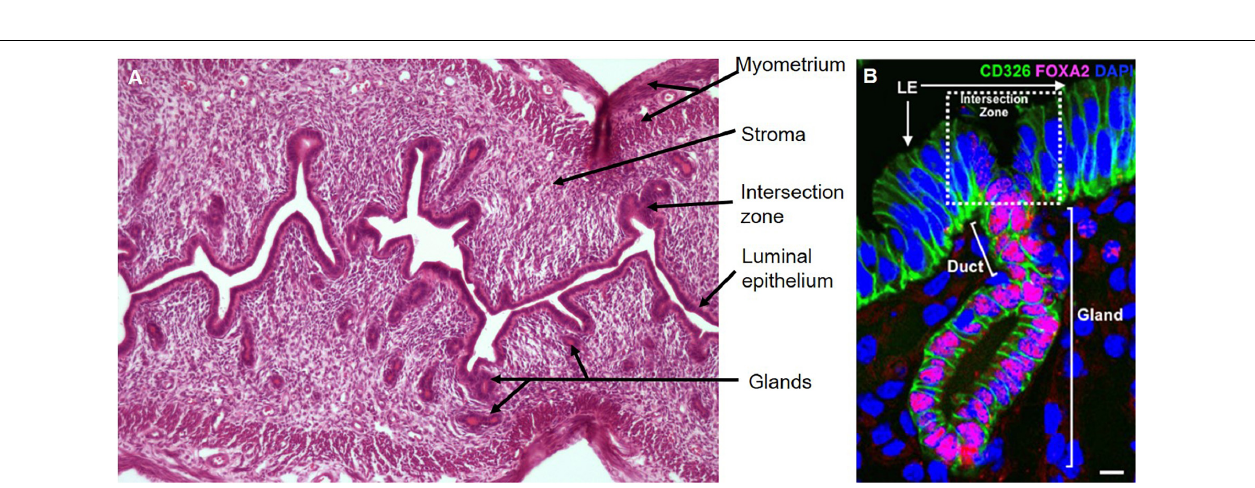
Frontiers in Cell and Developmental Biology |